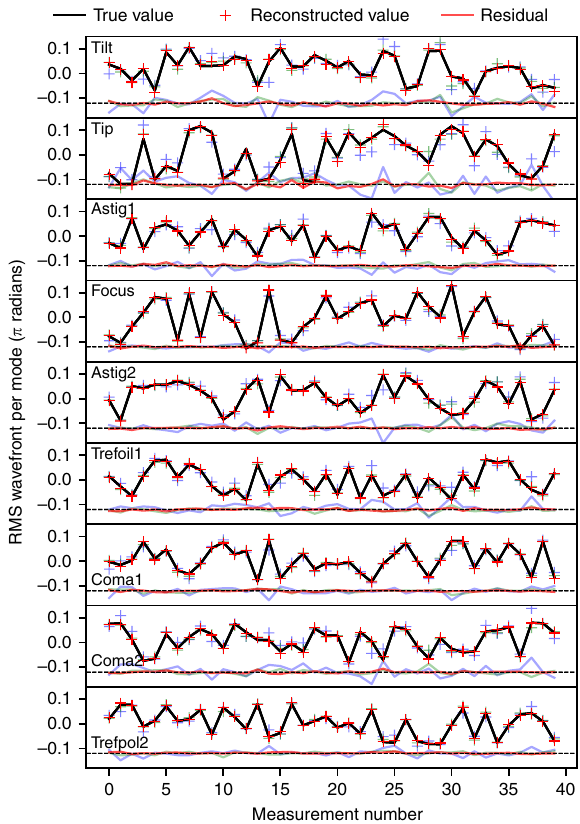
Fig. 5 Results of laboratory tests of the photonic lantern wavefront sensor. Shown here are the predicted Zernike coef fi cients (crosses) and the true values (black lines) for a randomly selected set of 40 measurements. Red points are predictions from a model trained with 48,000 measurements, green points with 4800 measurements and blue with 480 measurements. The difference between the predicted and true values is plotted at the bottom of each panel. Each measurement consists of a combination of the fi rst 10 Zernike terms each with a randomly chosen amplitude between approximately − 0.12 π and 0.12 π radians applied to the SLM. Resulting combined wavefronts for each measurement have peak-to- valley amplitudes of order π radians (limited by SLM hardware). Predictions are performed by the neural network described in the text, using the 19 output intensities of the lantern. The neural network accurately predicts the Zernike terms of the wavefront injected into the lantern, with a root-mean- squared-error of 5.1 × 10 − 3 π